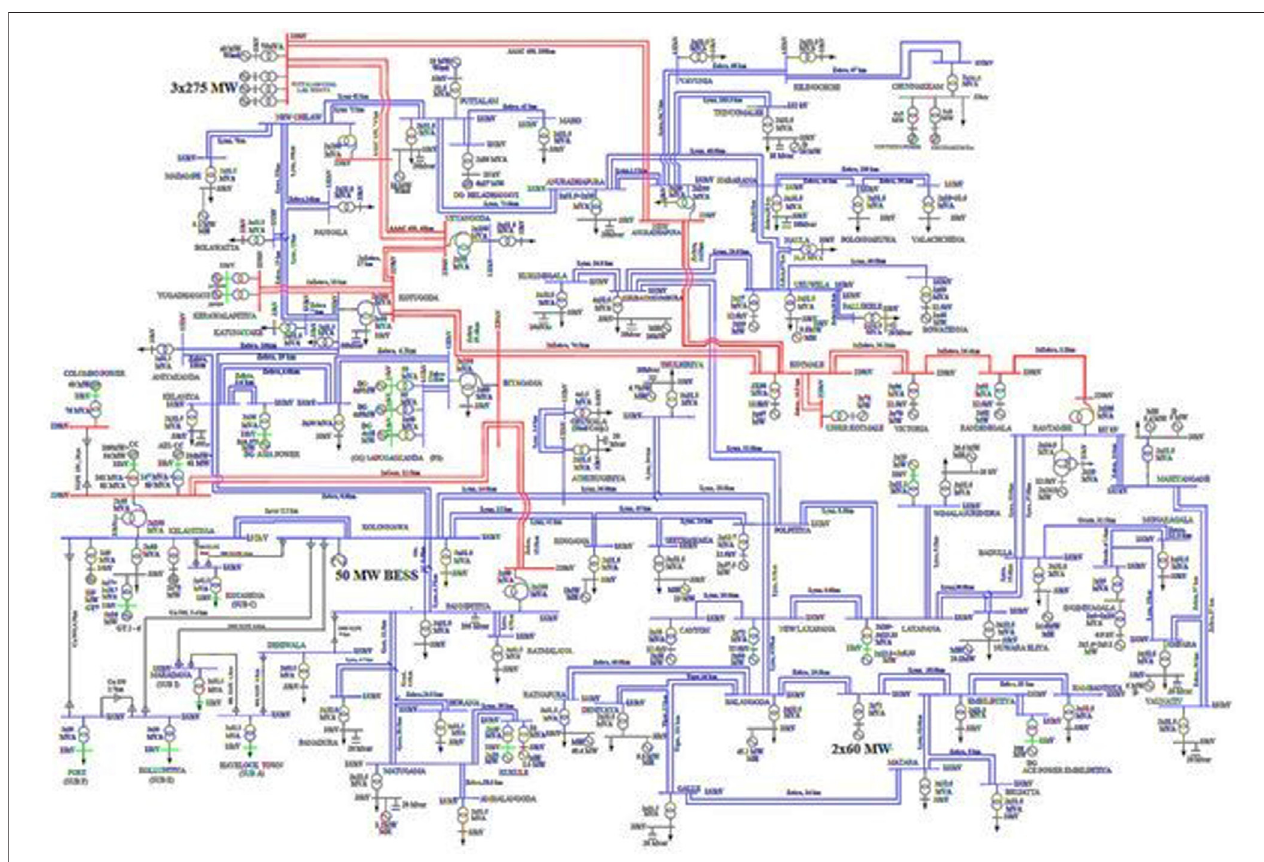
FIGURE 3 | 50 MW BESS connected to Kolonnawa bus.